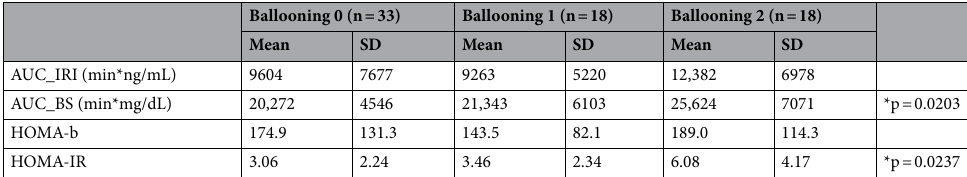
Table 3. Comparison of glucose metabolic markers among three groups with different ballooning grades. HOMA homeostasis model assessment, IR insulin resistance; AUC area under curve; BS plasma sugar; IRI serum insulin. *Indicates a statistical significance between ballooning grades 0 and 2.